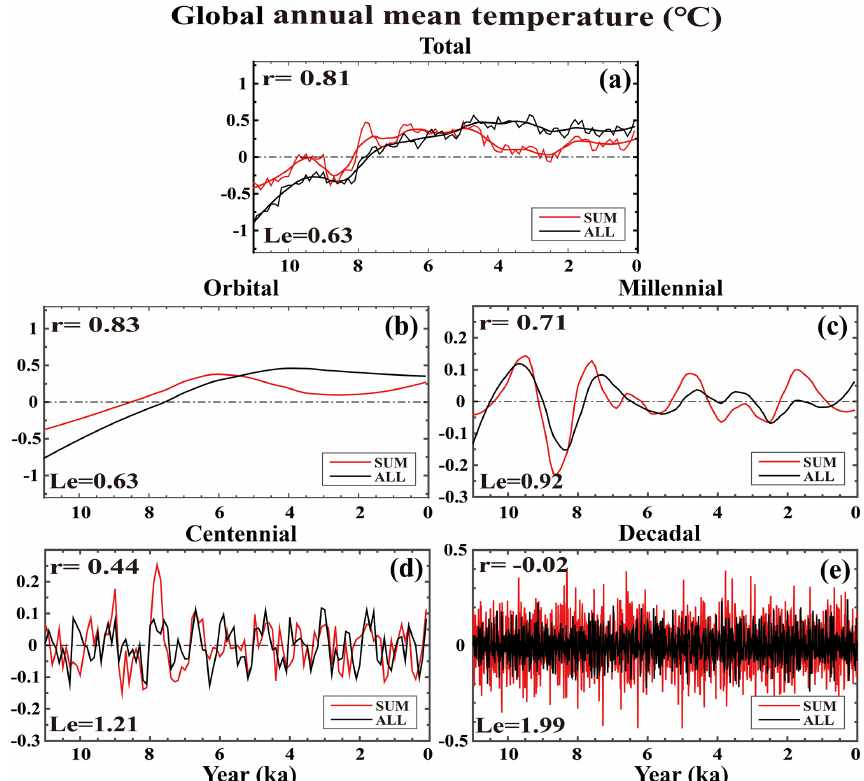
Figure 1. The global annual mean surface temperature time series derived from the ALL run (black) and the SUM (the sum of four single forcing runs, red). In (a) , the thin line is the 100-year binned time series; the thick line is 2500-year Loess-fitted time series. The orbital-scale variability (b) is represented by the 6500-year Loess-fitted series. The millennial variability (c) is represented by the 2500-year Loess-fitted data subtracting the 6500-year Loess-fitted data. The centennial variability (d) is represented by the 100-year binned data subtracting the 2500-year Loess-fitted data. The decadal variability (e) is represented by the 10-year binned origin time series subtracting its 100-year running mean. The correlation coefficient ( r ) is given at the upper left corner and the linear error ( L e ) is given at the lower left corner of each panel. The x axis is year (ka, 0 is 1950CE), and the y axis is temperature anomaly ( ◦ C, relative to